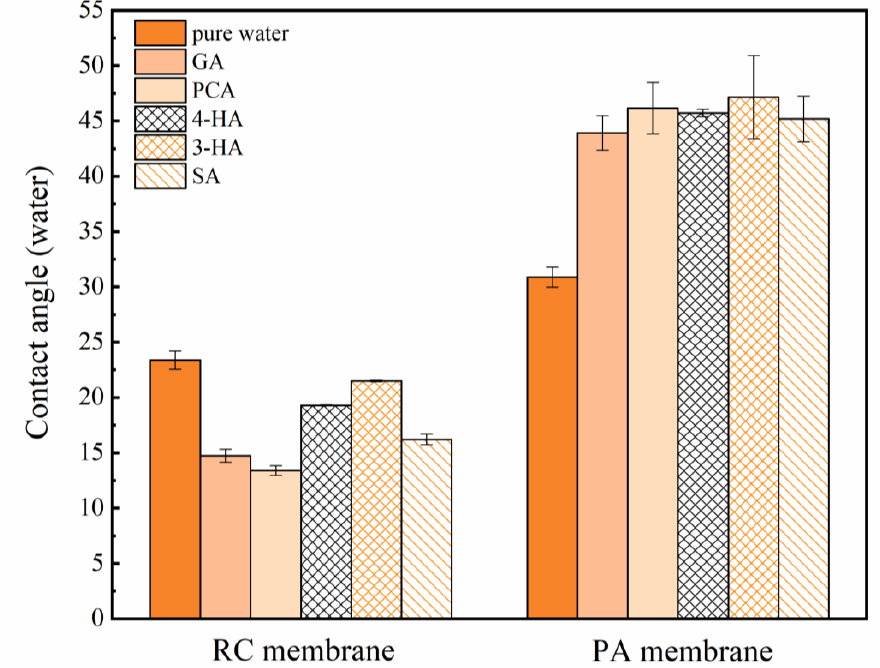
Figure 3. Pure water flux before and after the adsorption of SA on the two membranes. Experimental conditions: 2 bar; feed concentration = 10 mM and 25 ± 2 °C.